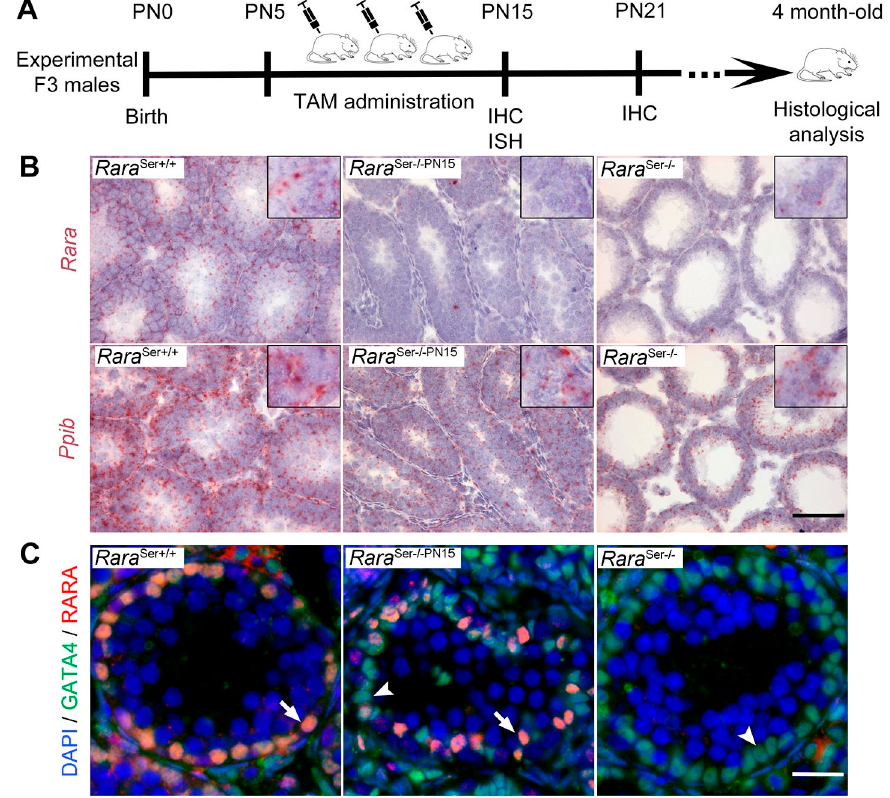
Figure 5. Evidence for ablation of Rara gene in postnatal Sertoli cells. ( A ) Diagram illustrating the time-course of TAM administration to F3 Rara L2/L2 and Sox9-CreER T2 Tg/0 / Rara L2/L2 experimental males (see also Figure S2). Pups were intraperitoneally injected with TAM three times, every other day, between PN5 and PN15 and analyzed at the time points as indicated. ( B ) ISH showing expression of Rara and Ppib mRNA on testis sections with the indicated genotype at PN15. Nuclei were counterstained with hematoxylin (light blue signal). Few red dots revealing Rara mRNA were observed in testis sections from Rara Ser − / − and Rara Ser − / − PN15 mutant males, while numerous red dots were detected in the Rara Ser+/+ control testis (left panel). As expected, abundant red dots revealing the ubiquitous Ppib mRNA were evidenced in each sample. Insets show higher magnifications. ( C ) IHC showing expression of RARA (red signal) and GATA4 (green signal) on testis sections with the indicated genotype at PN15. Overlapping signals yield an orange staining. Nuclei were counterstained with DAPI (blue signal). Arrows and arrowheads point to RARA-positive and RARA-negative Sertoli cell nuclei, respectively. Scale bar: 60 µ m in (B); 25 µ m in ( C